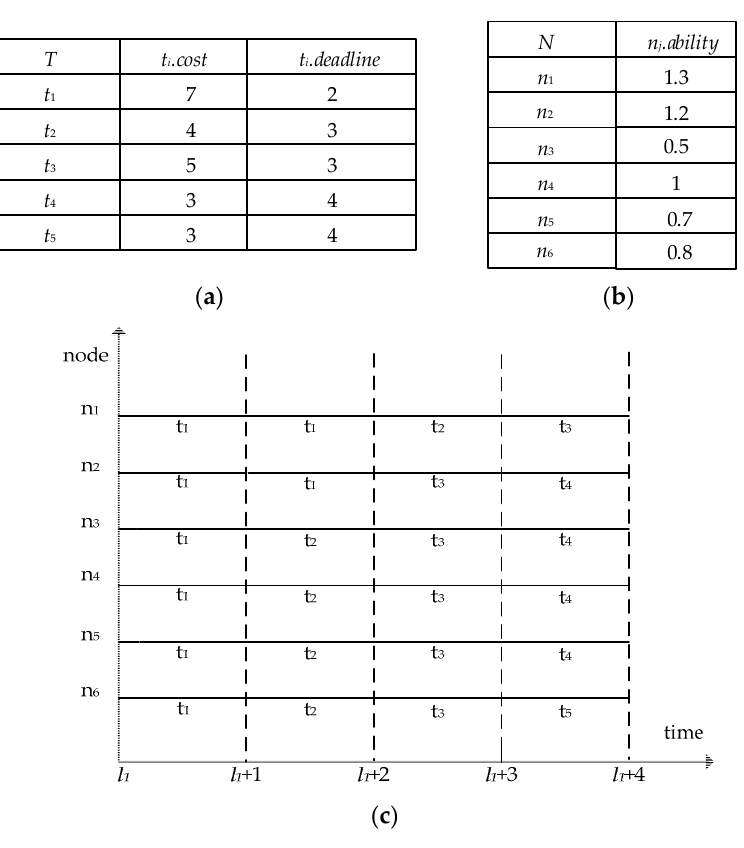
Figure 3. Task list and volunteer nodes list at time l 1 + 1. ( a ) List of tasks at time l 1 + 1; ( b ) list of volunteer nodes at time l 1 + 1.